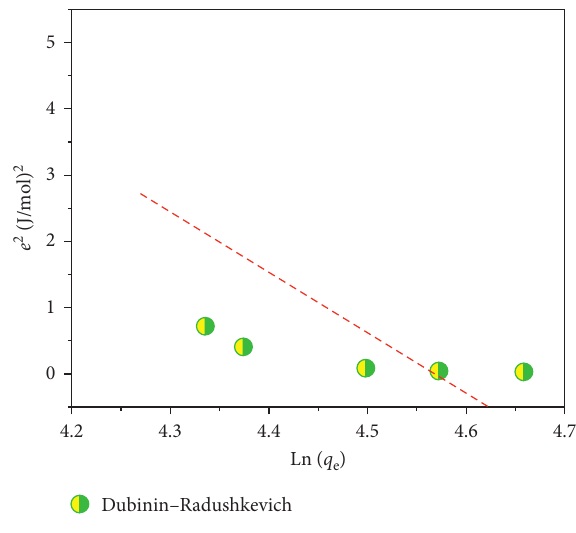
Figure 12: D-R isotherm plot.